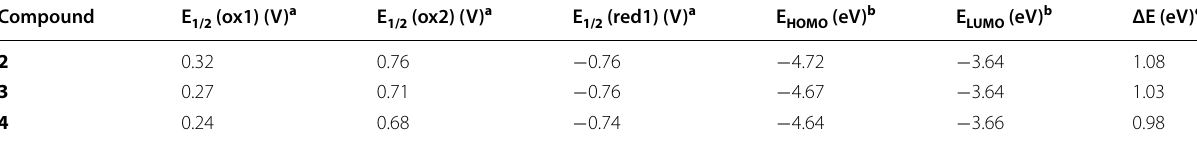
Table 2 Electrochemical data of 2–4